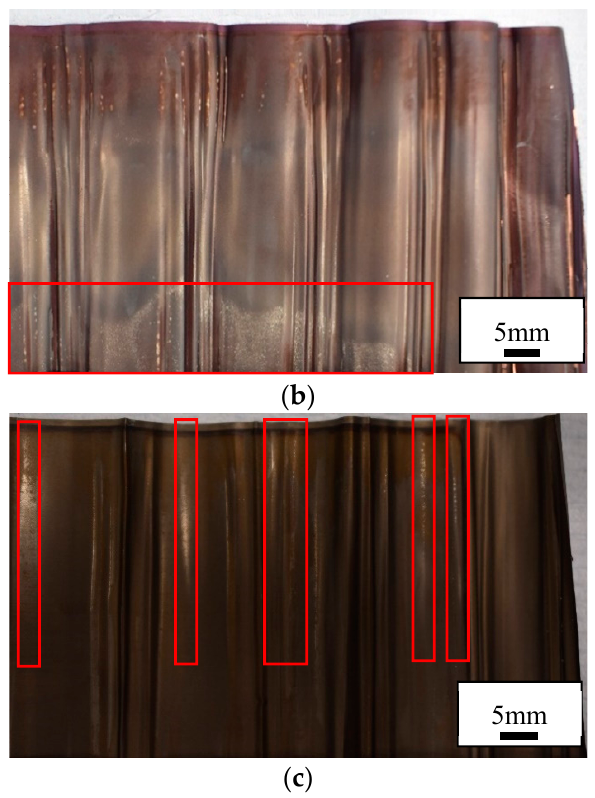
Figure 8. Surface examination of anode electrodes. ( a ) shows as received anode, ( b ) shows failure test cell anode and ( c ) shows high rate cycled cell anode. Plating is shown by red squares.